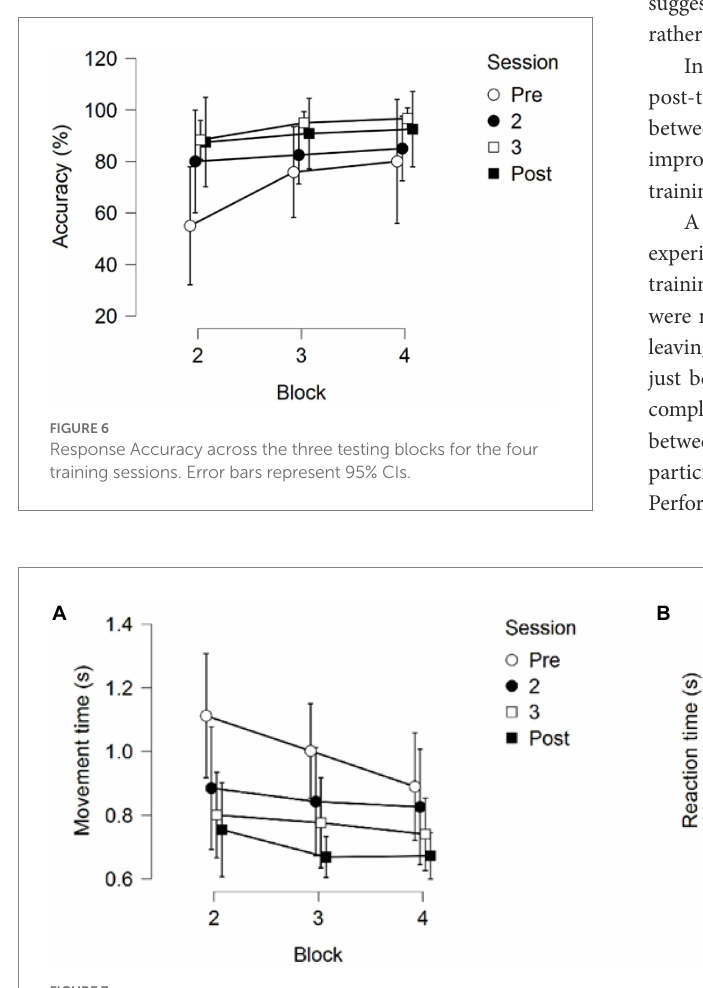
FIGURE 7 (A) Reaction time for the four training sessions across the three testing blocks. (B) Movement time for the four training sessions across the three testing blocks. Error bars represent 95% CIs between groups.